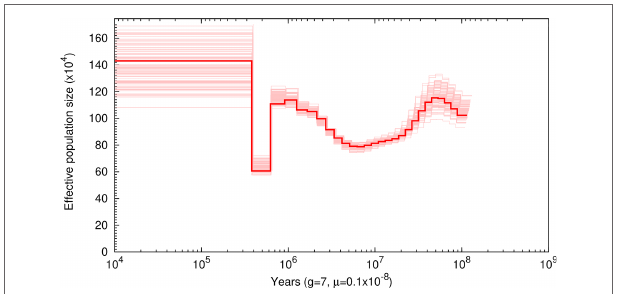
FIGURE 3 | Demographic history of Chiloscyllium plagiosum in this study. Thick lines represent the median, and thin light lines correspond to 100 rounds of